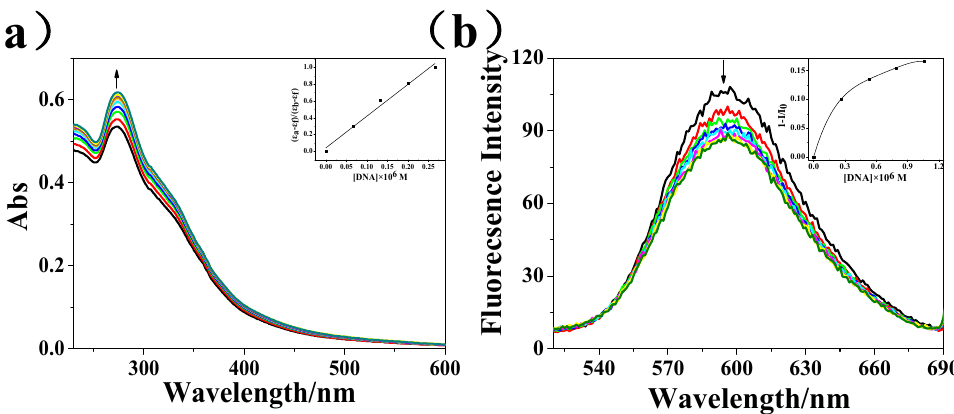
Figure 3. The study of the interaction between 1 with bcl-2 G-quadruplex DNA by spectroscopic methods. ( a ) The electronic spectra of 1 in absence and in presence of bcl-2 G-quadruplex DNA. [ 1 ] = 60 μ M, [DNA] = 100 μ M; ( b ) Emission spectra of EB and bcl-2 G-quadruplex DNA in the incubation buffer in the absence and presence of 1 , [EB] = 16 μ M, [DNA] = 2 μ M.